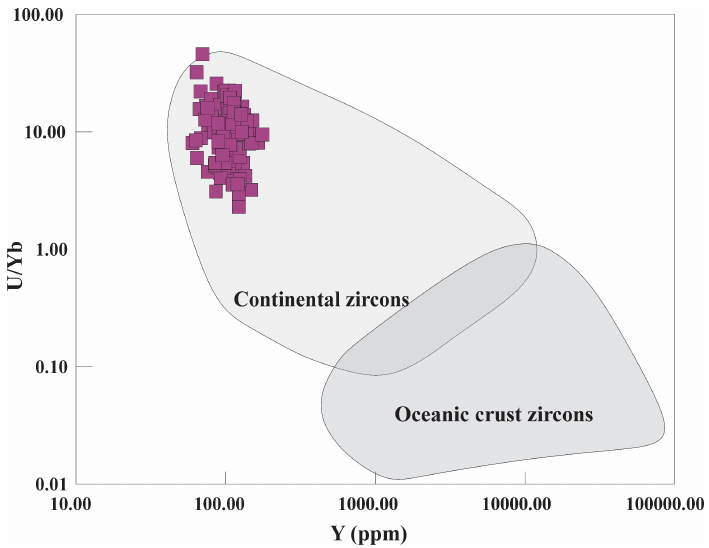
Figure 14. Y vs. U/Yb zircon discrimination diagram [76].